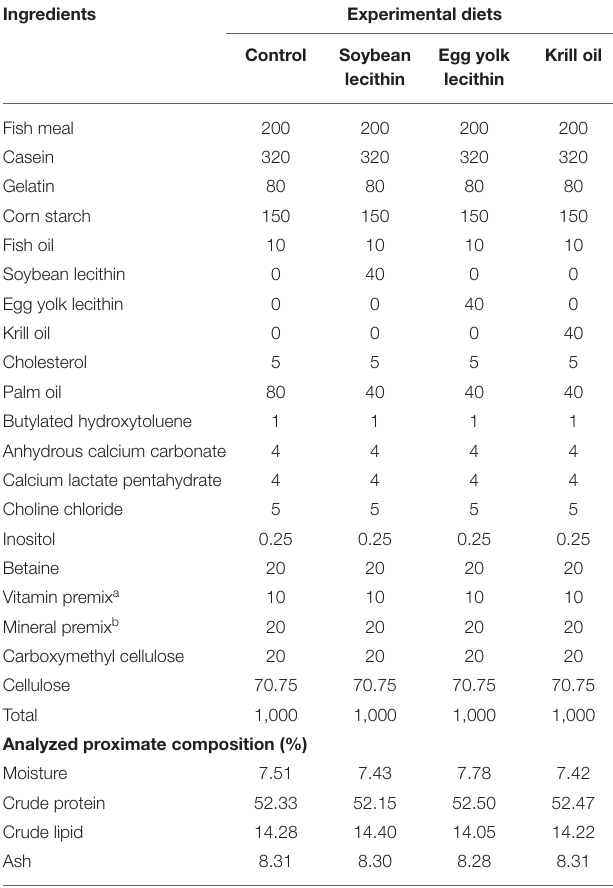
TABLE 1 | Ingredient formulation (g/kg dry basis) and proximate composition (%) of the four experimental diets fed to female L. vannamei .